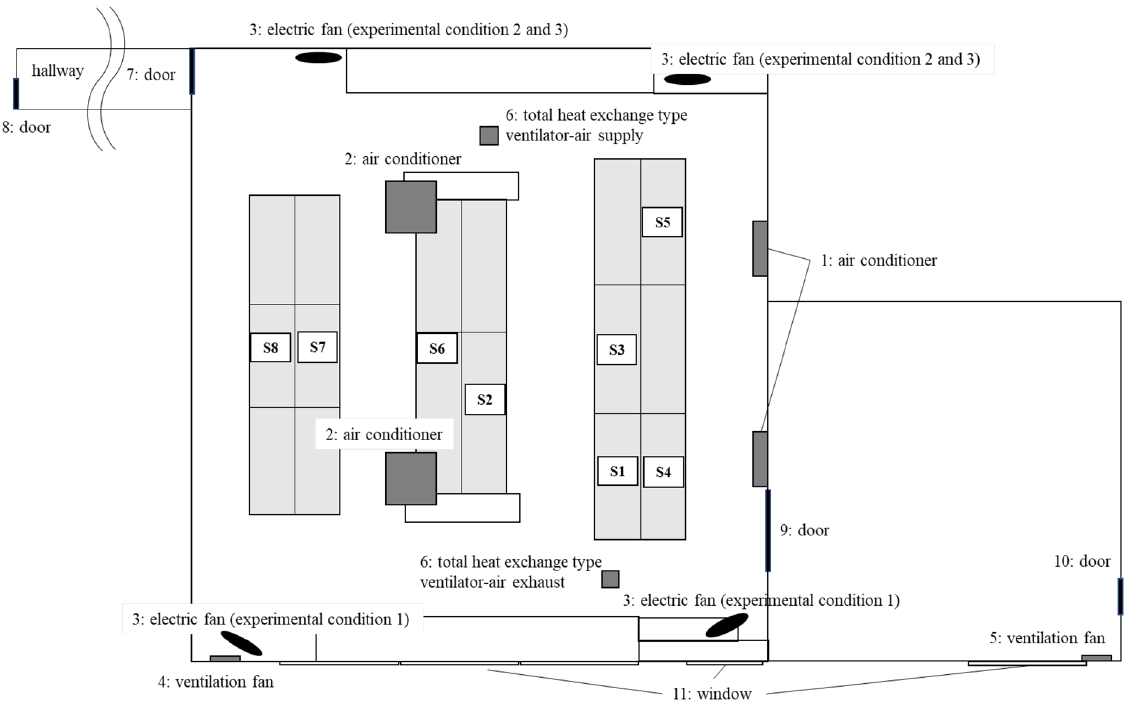
Figure 5. CO 2 sensor location and experimental